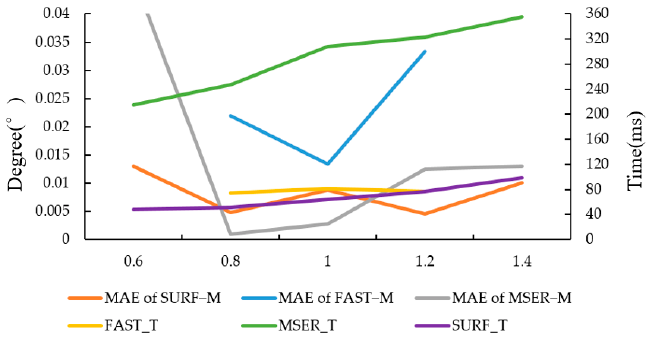
Figure 6. The result of FAST − M, SURF − M and MSER − M. MAE means mean absolute error, while FAST_T, MSER_T and SURF_T mean the running times of the algorithms, respectively.